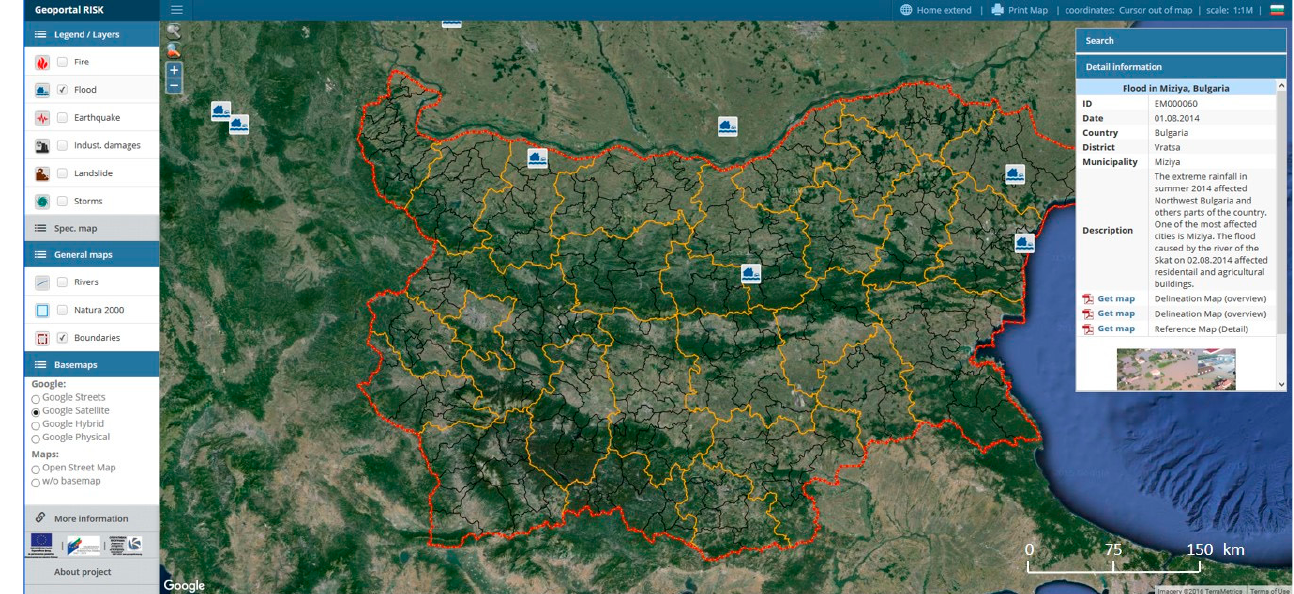
Figure 2. Copernicus Risk Relay